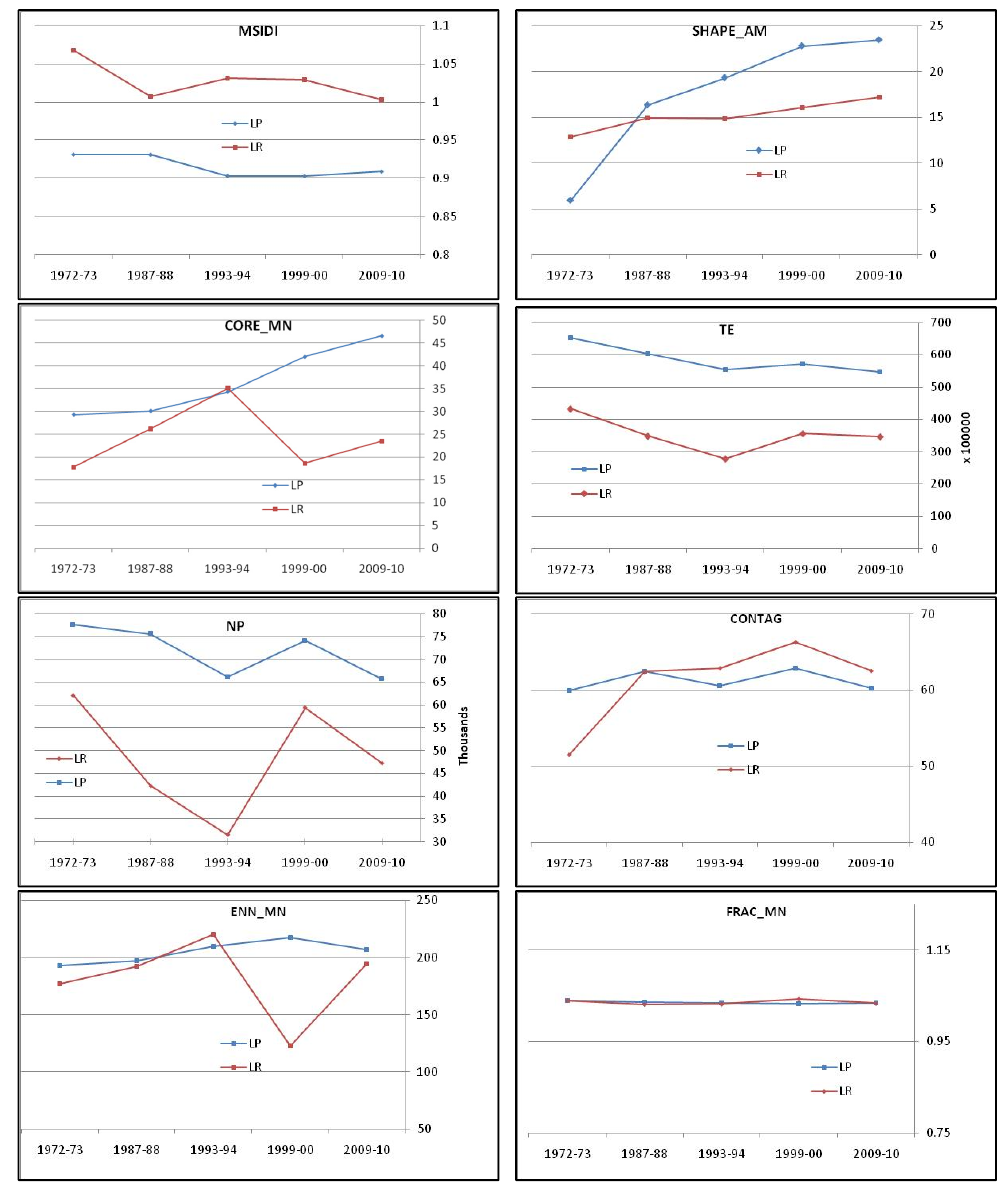
Figure 7. Changes in pattern metrics through time for the Liverpool Plains and the Liverpool